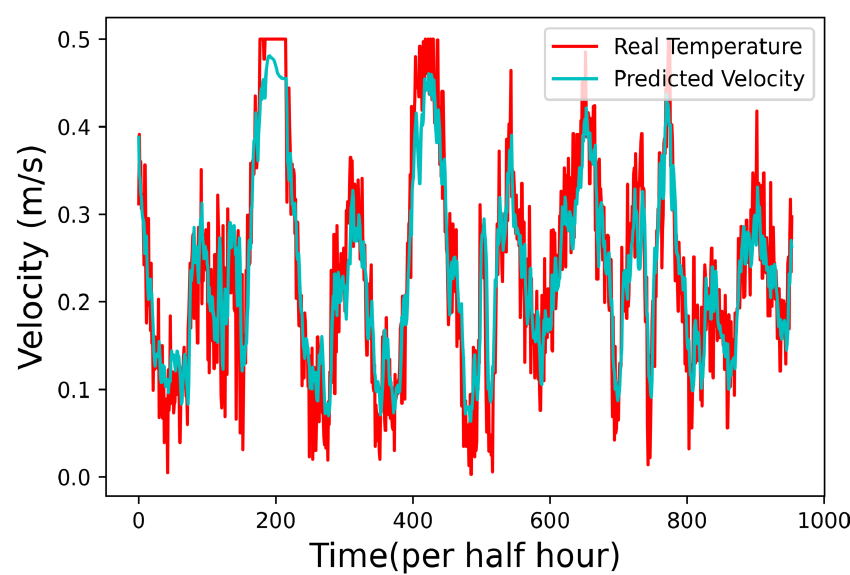
Figure 7. Prediction results of water